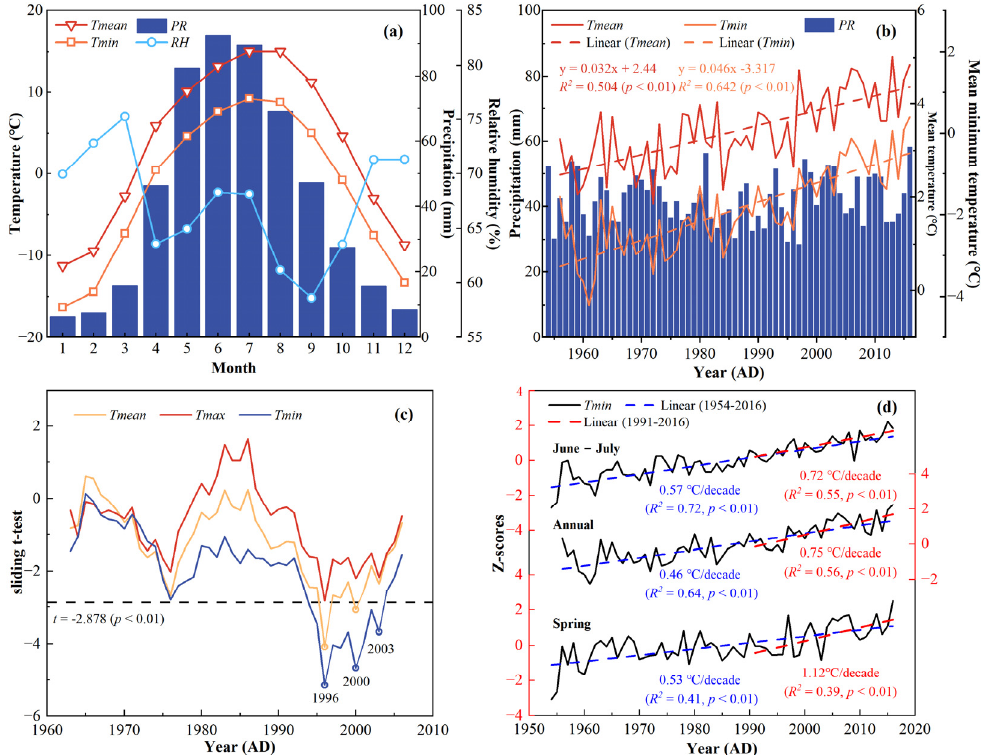
Figure 2. ( a ) Monthly climate variations in temperature, precipitation, and relative humidity. ( b ) Annual climate variations in temperature and precipitation (1954–2016 AD). ( c ) An abrupt change in Tmean , Tmax , and Tmin was detected by the sliding t -test. The dashed lines indicate the significance value at the 0.01 level. ( d ) Variations of Tmin in different seasons (1954–2016 AD). Pearson correlation analysis was performed to explore the association between TRW and climatic variables, and z-scores standardisation was used to improve the comparabil- ity of different data. A sliding t-test was used to detect the abrupt changes in temperature, based on whether the mean difference between two subsets exceeds a given significance level [41]. First-order difference processing, which is the difference between two adjacent terms, was applied to the raw sequence to avoid the influence of long-term trends and to reveal high-frequency variability. Commonality analysis (CA), based on a multiple linear regression relationship between independent variables and dependent variables, was used to disentangle the effects of multiple factors on TRW in the R statistical programming environment. The advantages of CA are that it can calculate the relative contribution of each predictor and can also give the common contribution between any combination of predictors [42]. 3. Results 3.1. Tree-Ring Width Chronology and Climate Change The standardised TRW chronology, the sample size, and the SSS are shown in Figure 3a, which retains both high-frequency and low-frequency climate signals [2]. The credible starting year of the TRW chronology is 1729, according to the SSS > 0.85 criterion [11]. Table 1 lists some of the statistical parameters of the chronology, where high mean sensi- tivity and high signal-to-noise ratio mean that the chronology is more sensitive to climate change and contains richer climate signals. High correlation coefficients (R1, R2, R3) indi- cate more consistent changes between samples. A high expressed population signal indi- cates that the chronology represents the population signal with sufficient quality. In ad- dition, the TRW index has an extremely intriguing trajectory; it increased significantly after the 1950s, reached a peak in 1998, and then fell into an abrupt decline (Figure 3).